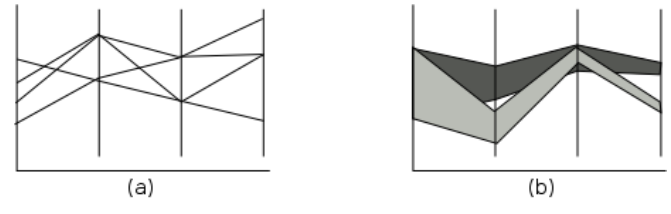
Fig. 6. Main difference between the way that data is represented in (a) parallel coordinates and (b) parallel